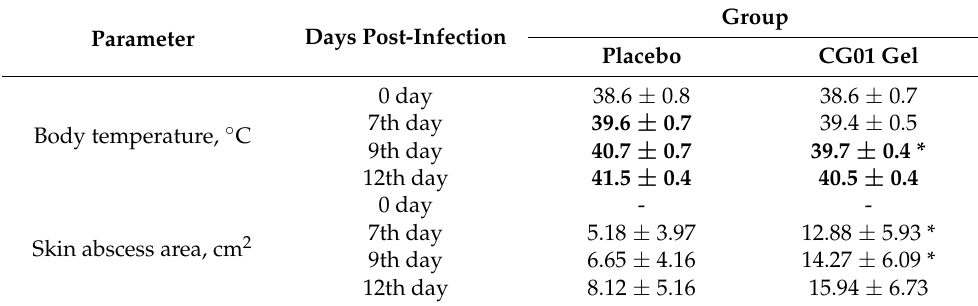
Table 1. Body temperature and abscess area data in the two investigated groups. Skin abscess area, cm Group Days Post-In- Parameter fection Placebo CG01 Gel